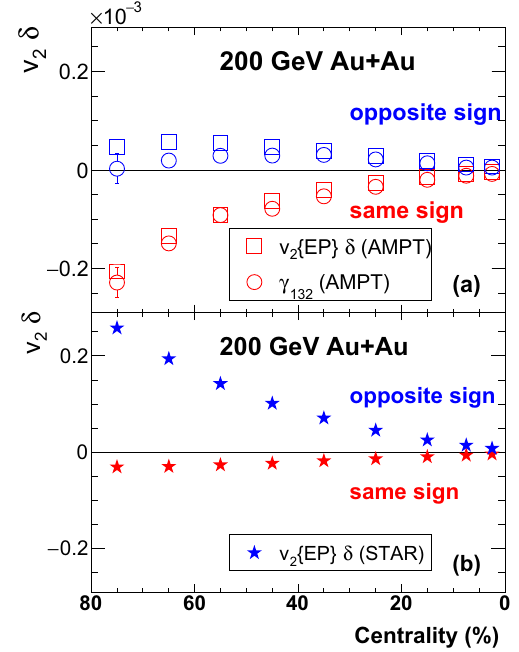
Fig. 6 Centrality dependence of v 2 δ from AMPT (upper) and from √ s NN = 200 GeV. The γ 132 STAR data (lower) in Au+Au collisions at results from AMPT are also shown in comparison. The v 2 δ values in the lower panel come from the STAR measurements of v 2 [32] and δ